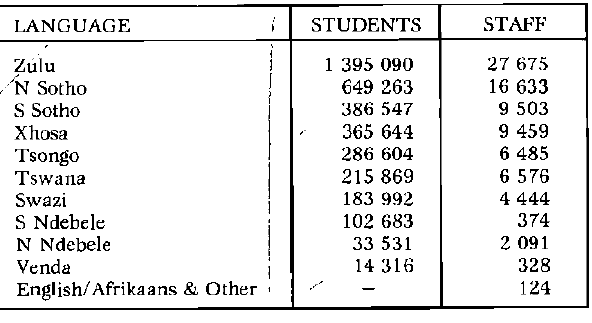
Table 1: Mother-tongue language used by students and staff in primary schools in DET for 1987*